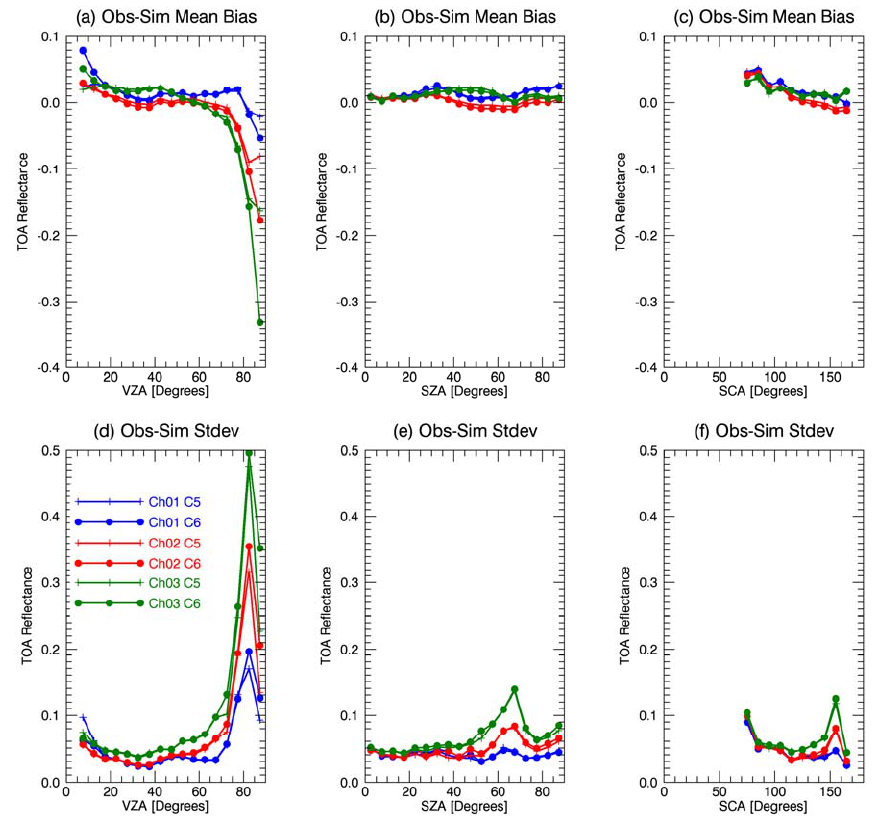
Figure 4. ( a ) Observations minus simulations mean bias of the TOA reflectances as a function of the viewing zenith angle (VZA); ( b ) Same as ( a ) as a function of solar zenith angle (SZA); ( c ) Same as ( a ) as a function of the scattering angle (SCA); ( d – f ) Standard deviation of the observations minus simulations TOA reflectances as a function of VZA, SZA, and SCA, respectively. The different colored lines and styles refer to the Moderate Resolution Imaging Spectroradiometer (MODIS) collection and SEVIRI channels as explained in the